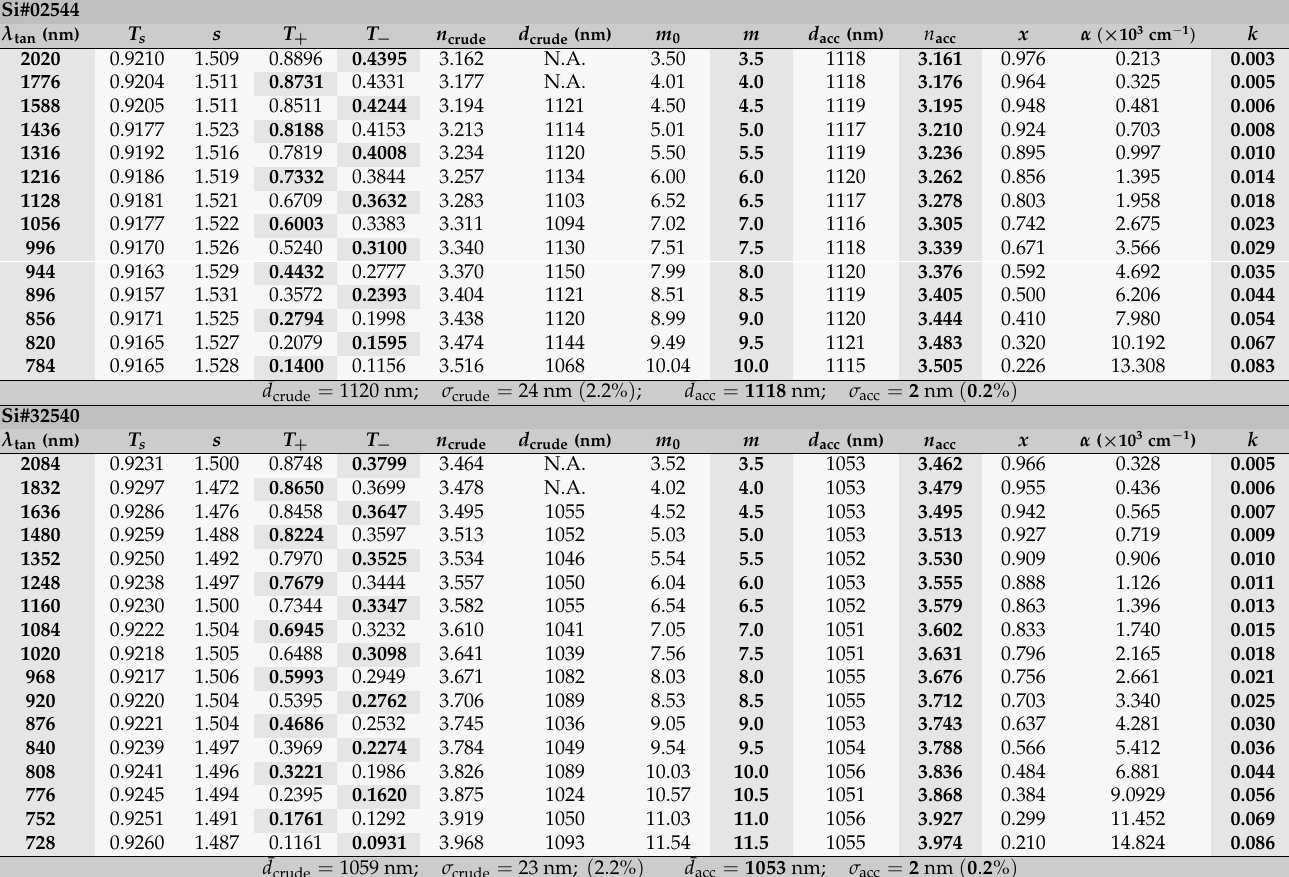
Table 3. Optical and geometrical characterizations method for the two representative samples, Si#02544 and Si#32540, grown by using the highest Ar working-gas pressures of 4.4 and 4.0 Pa, respectively. Values of the optical and geometrical parameters, λ tan , T s , s , T + , T − , n crude , d crude , m 0 , m , d acc , α , and k , calculated from their respective normal-incidence transmittance spectra, by employing to that end the Swanepoel transmission-envelope approach. The meaning of all the symbols are fully explained in the text. The values of T + and T − in bold character refer to the actual ‘measured’ value of transmission, while the other one belongs to the calculated envelope.